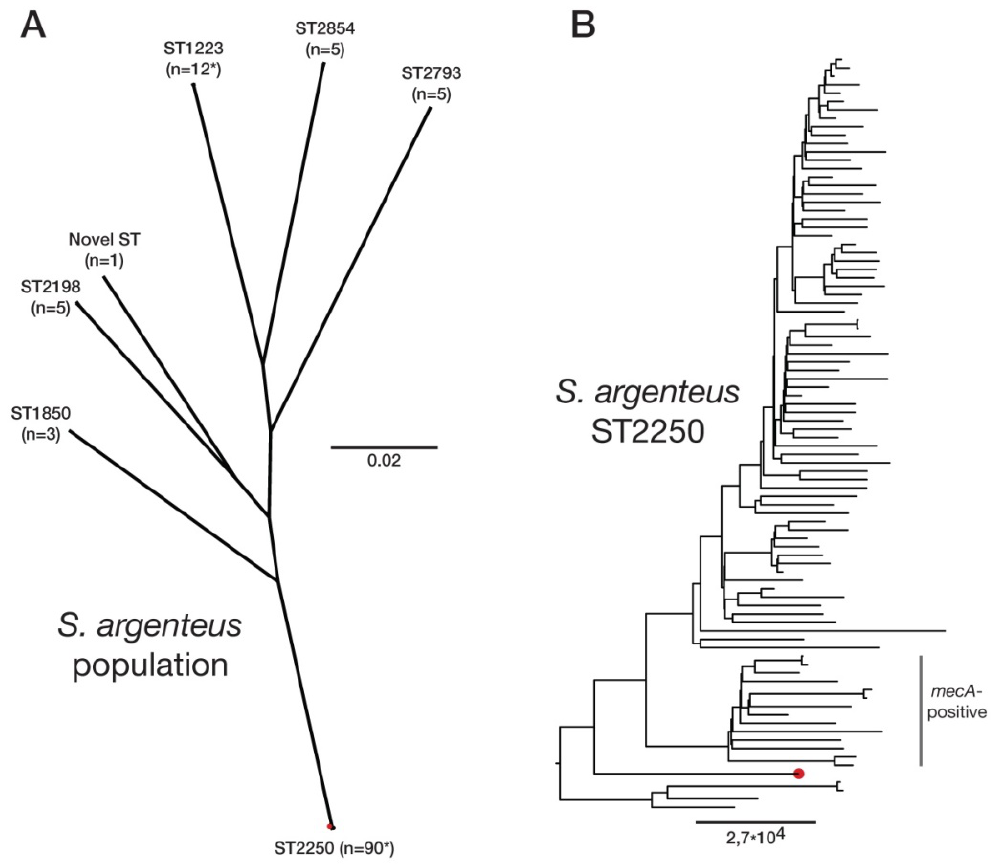
Figure 1. Phylogenetic clustering of Staphylococcus argenteus . ( A ) Unrooted phylogeny based on 52,329 SNPs depicting all available S. argenteus genome sequences available in the NCBI Reference Sequence database (n=120) and the isolate from this study. Sequence types (STs) and number of isolates per clade is highlighted with * indicating the presence of other STs. ( B ) Detailed rooted phylogeny of the ST2250 clade where MRSA isolates are noted as are the Swedish PJI isolate in red. Scalebar indicate substitutions per